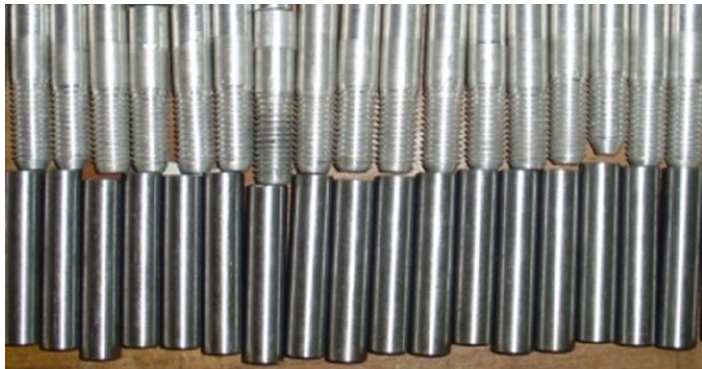
Figure 3. AA6061-5% B 4 C/AISI 1030 steel samples.